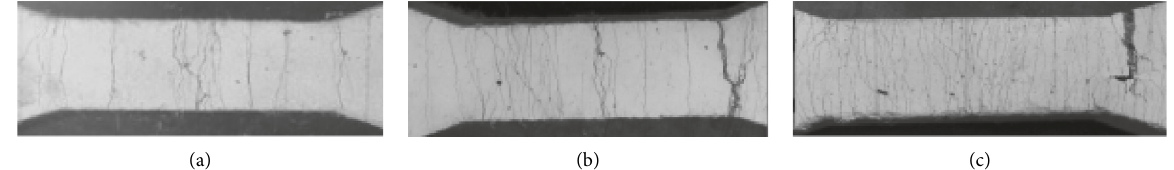
Figure 4: Failure phenomenon of the PE-ECC with the water-binder ratio of 0.27 and different FA contents and: (a) 7 days, (b) 28 days, (c) 60 days.